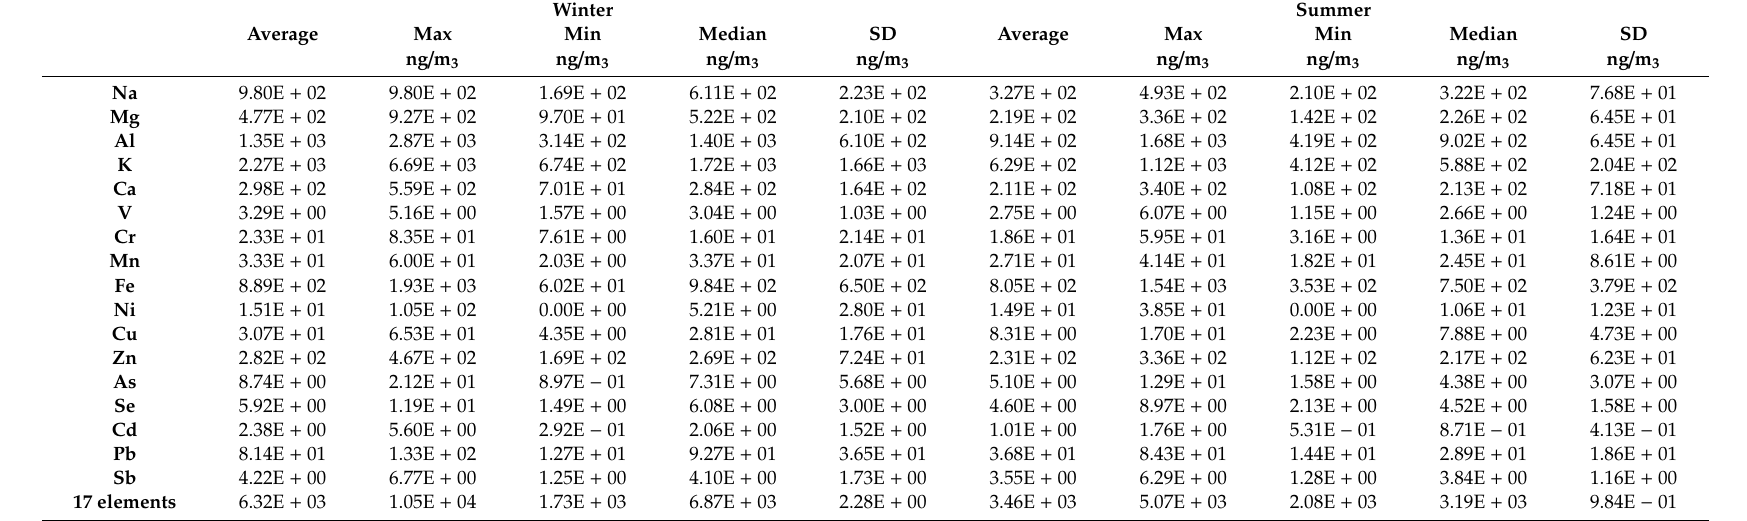
Table 1. The average, max, min. median and standard deviation (SD) of each elemental content during winter and summer sampling periods. Winter Summer Average Max